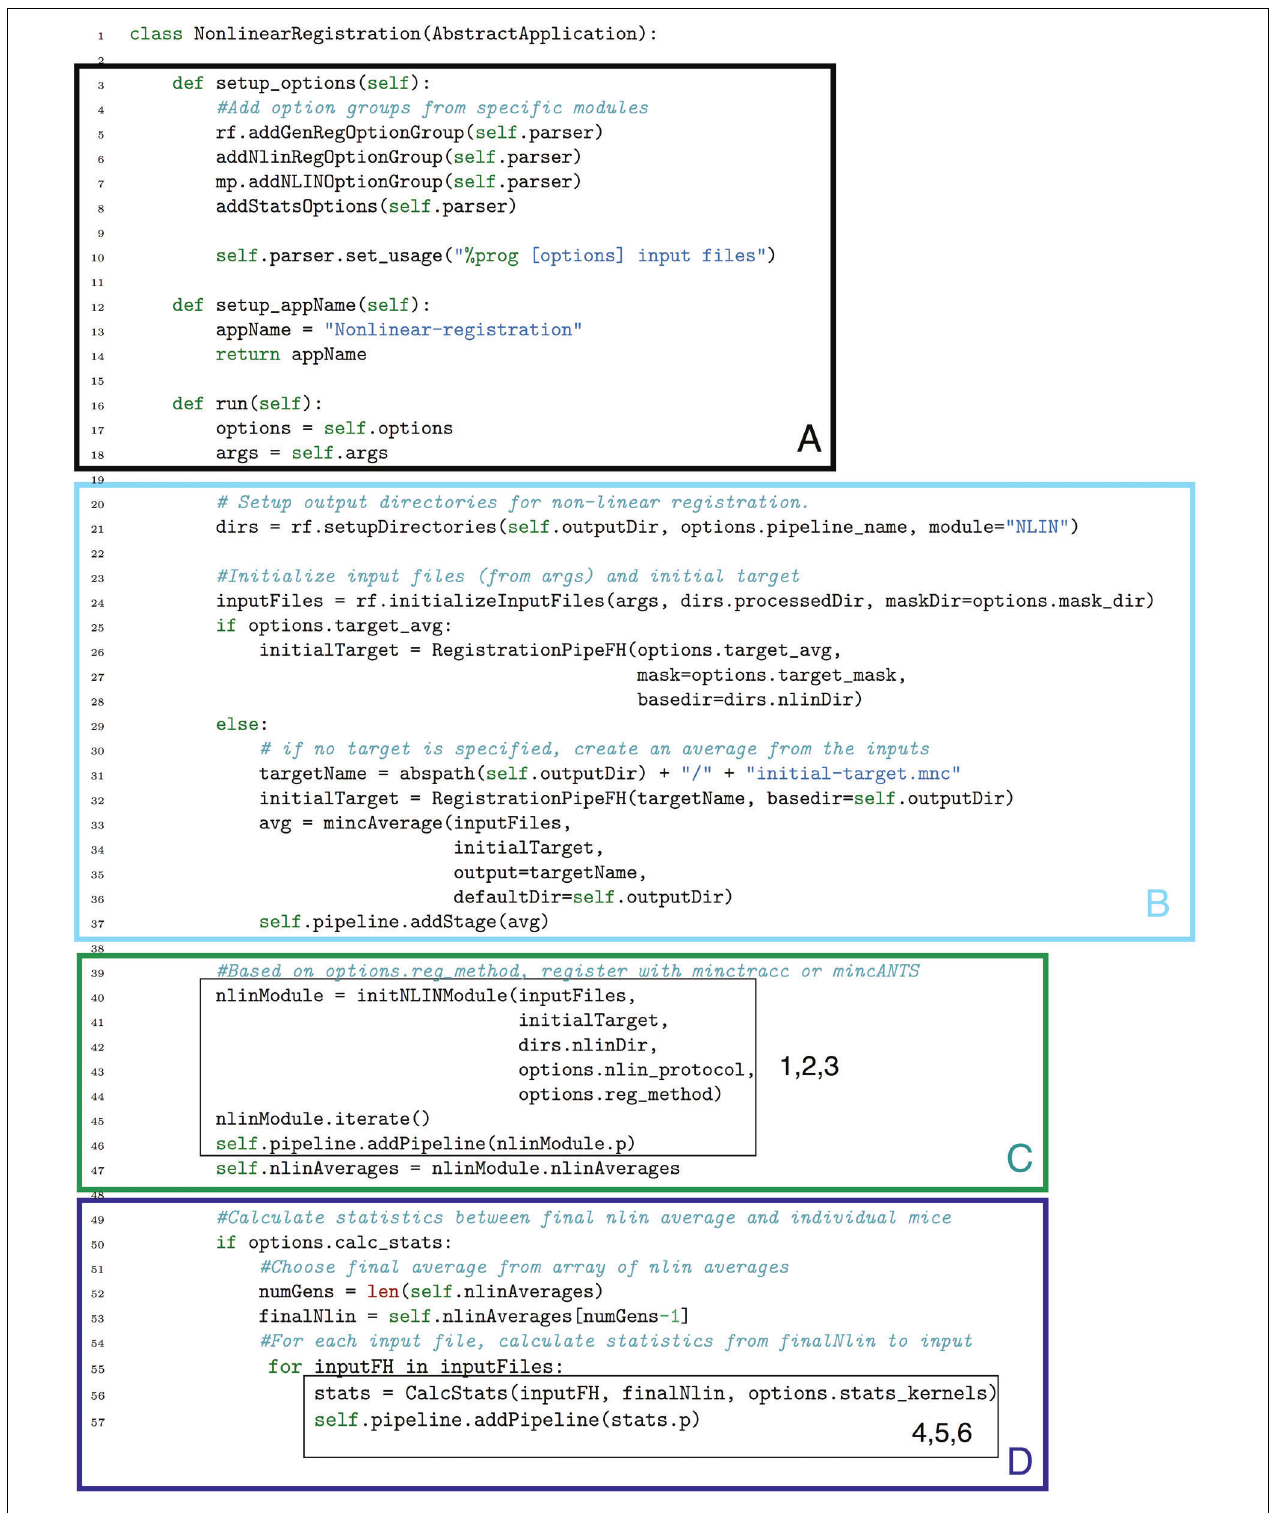
FIGURE 14 | Non-linearRegistration application in Pydpiper. This code aligns a set of inputs toward a common target, iterating over multiple generations if requested. Note that we have omitted if __name__ = "__main__" from this figure, but it is included in